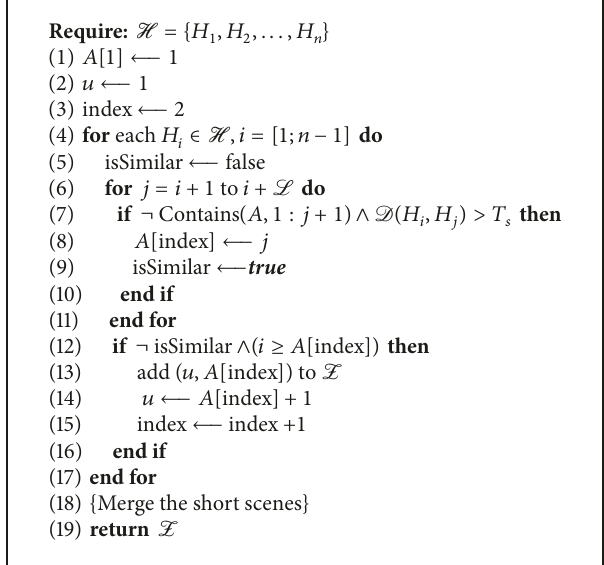
Algorithm 1: Scene detection